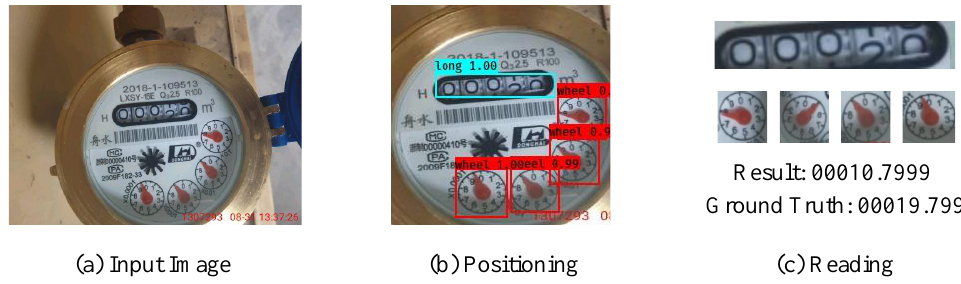
Figure 4. Failure case of incorrect reading caused by the inaccurate localization for the digit